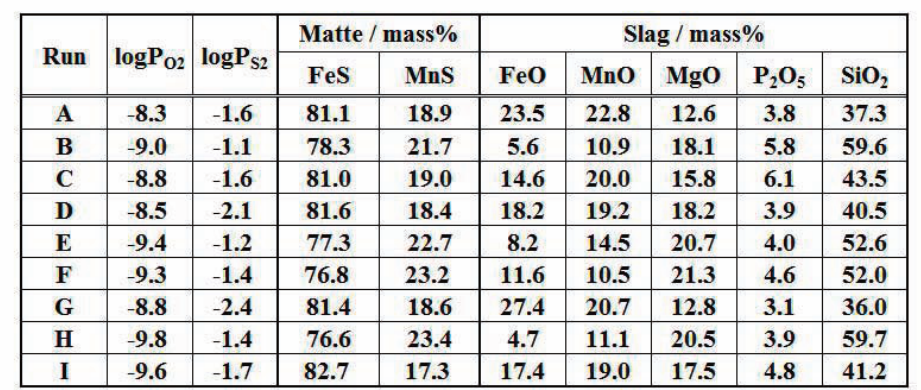
Table 5. Matte and slag compositions of series 2 after revising the suspended phases.